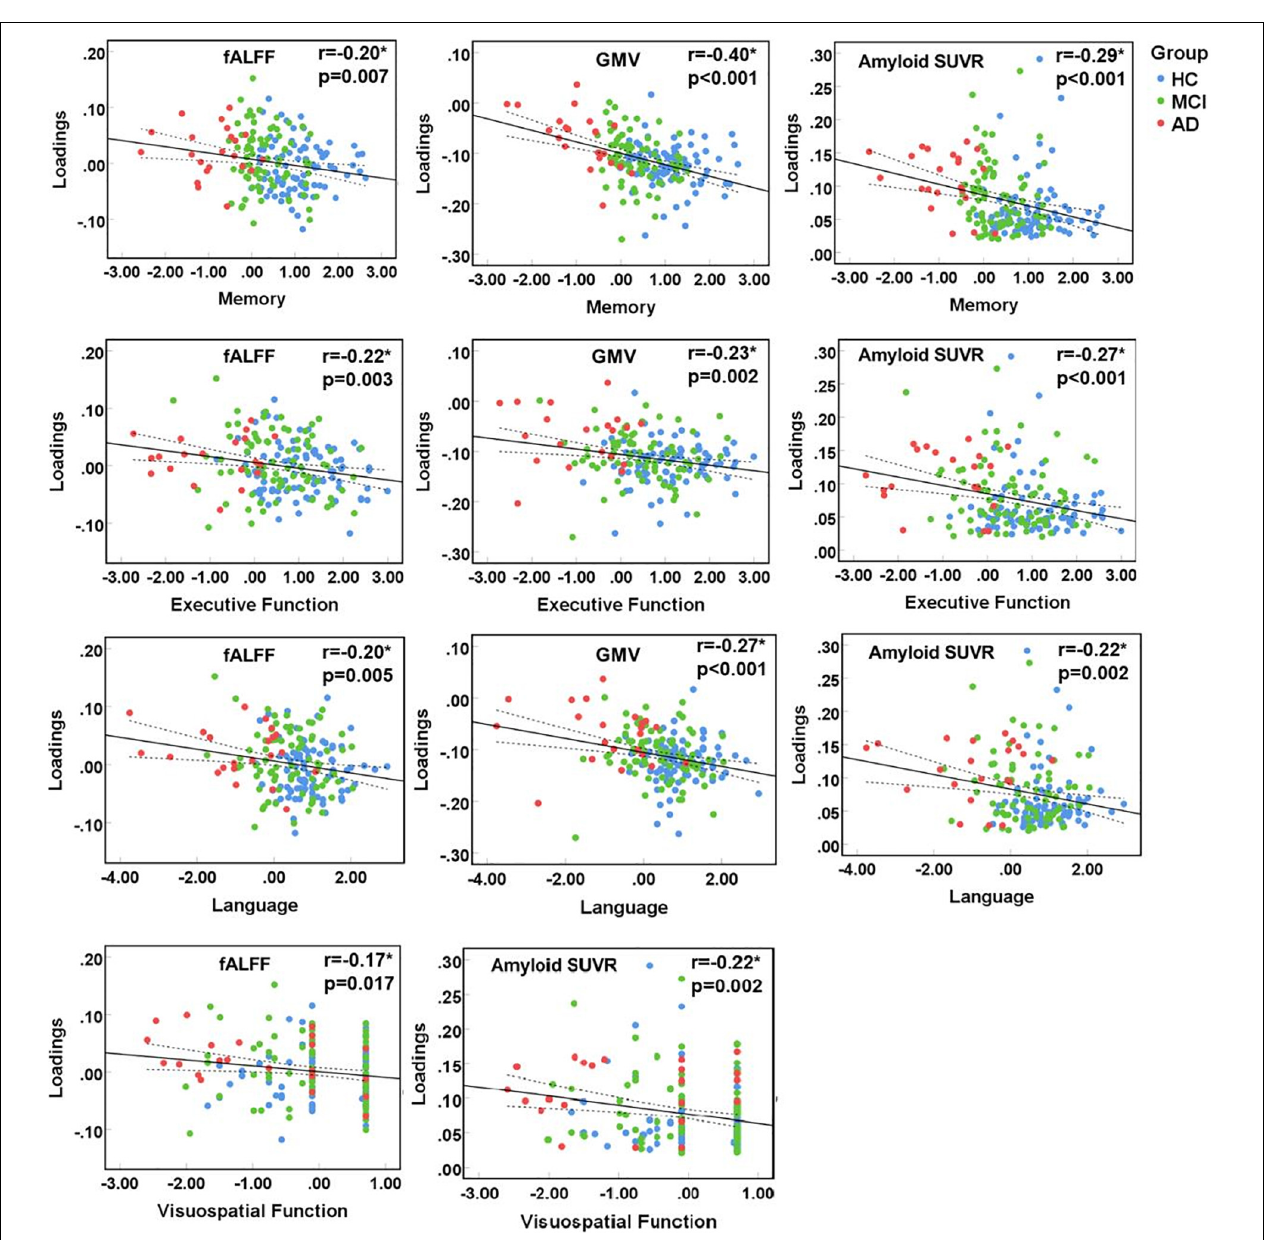
FIGURE 3 | Correlation between loadings of the identified joint component and cognitive function. *Significant at p < 0.05, FDR corrected. HC, healthy control; MCI, mild cognitive impairment; AD, Alzheimer’s disease; fALFF, fractional amplitude of low frequency fluctuations; GMV, gray matter volume; SUVR, standard uptake value